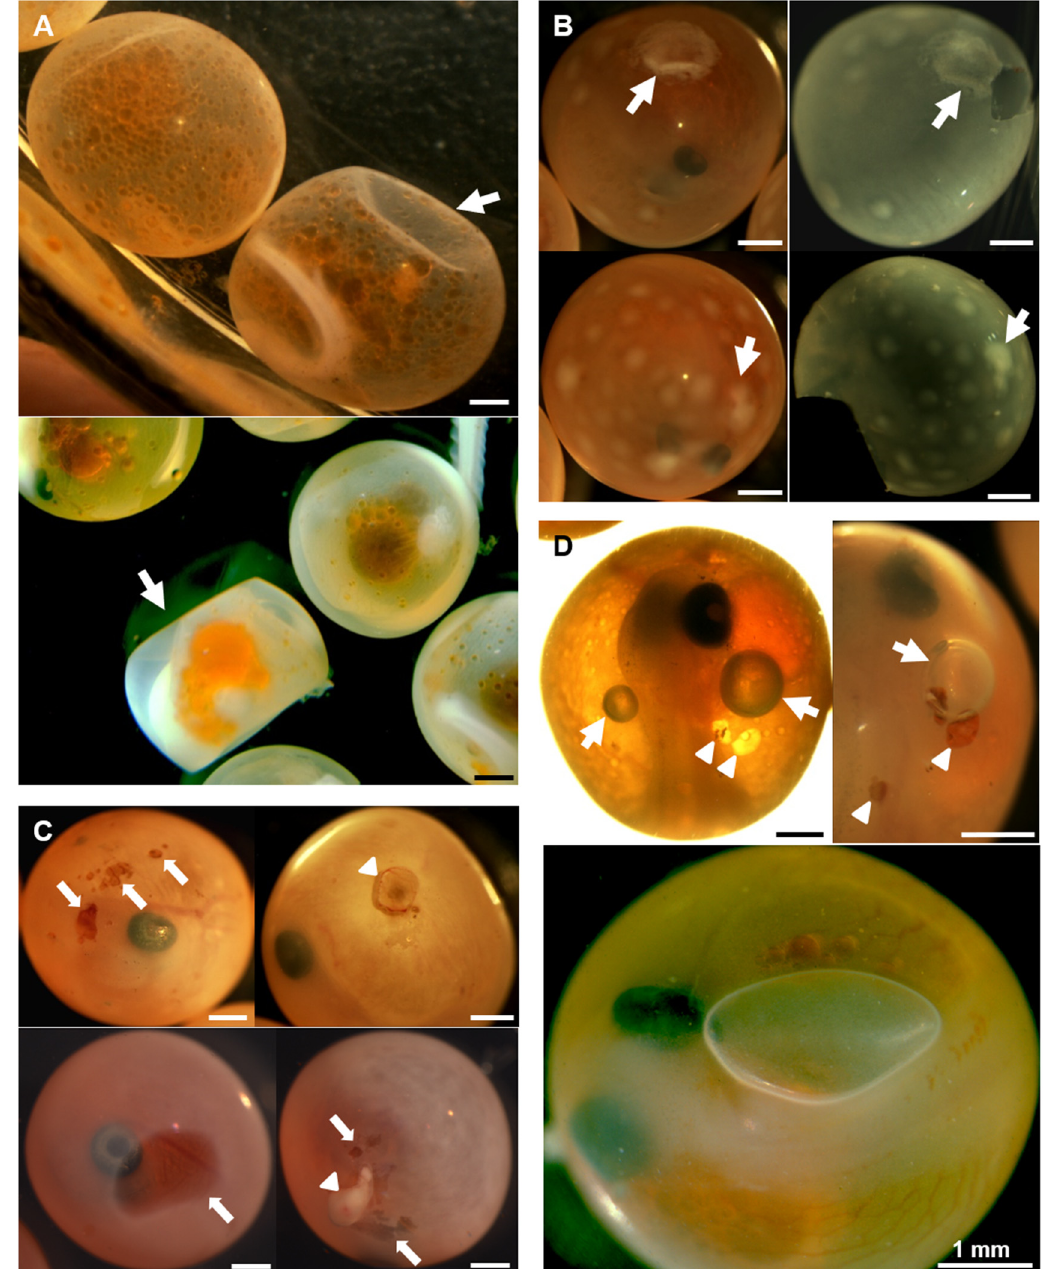
Figure 2. Chorion alterations: ( A ) Soft chorion. Representative examples of normal and soft chorion (arrows) in Atlantic Salmon (upper panel), and Rainbow Trout (lower panel) eyed-eggs. ( B ) White-spotted chorion. White spots (arrows) on chorion before (left panel) and after (right panel) chorion removal in Atlantic Salmon eyed-eggs. ( C ) Perforated chorion. Representative examples of eyed-eggs displaying variable size holes (arrows) and extrusion of the yolk sac (arrowhead; right panel) in Atlantic (upper panel) and Coho (lower panel) Salmon. ( D ) Bubbles in eyed-eggs. Example of Atlantic Salmon (upper panel) eyed-eggs displaying holes (arrowheads) and unidentified gas bubbles (arrows) in the perivitelline space. Rainbow Trout (lower panel) eyed-egg exhibiting a large gas